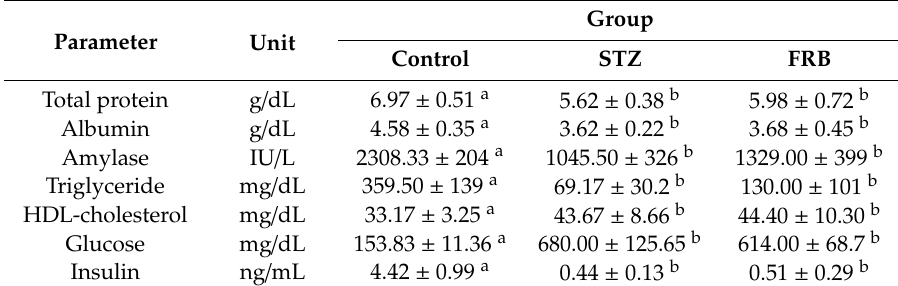
Table 3. Blood profile of STZ-induced diabetes after one-month treatment. Parameter